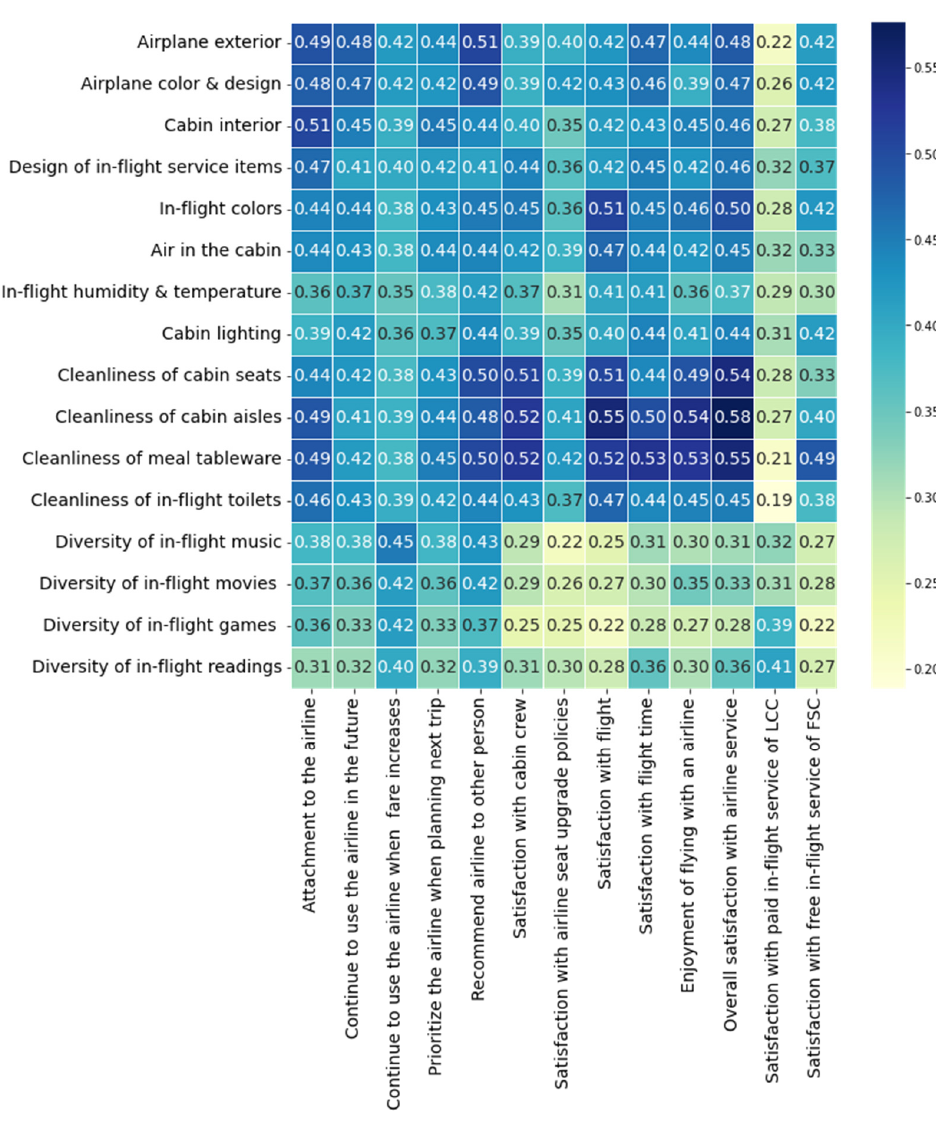
Figure 2. Correlation matrix between physical servicescape factors and customer churn risk and customer satisfaction factors.